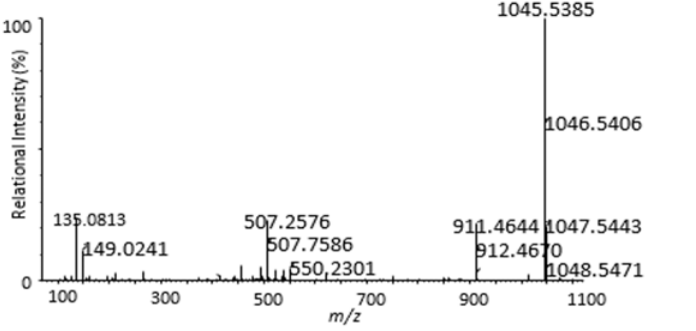
Fig 4. Liquid chromatogram-mass spectrum (LC-MS) profile of MC-YR.